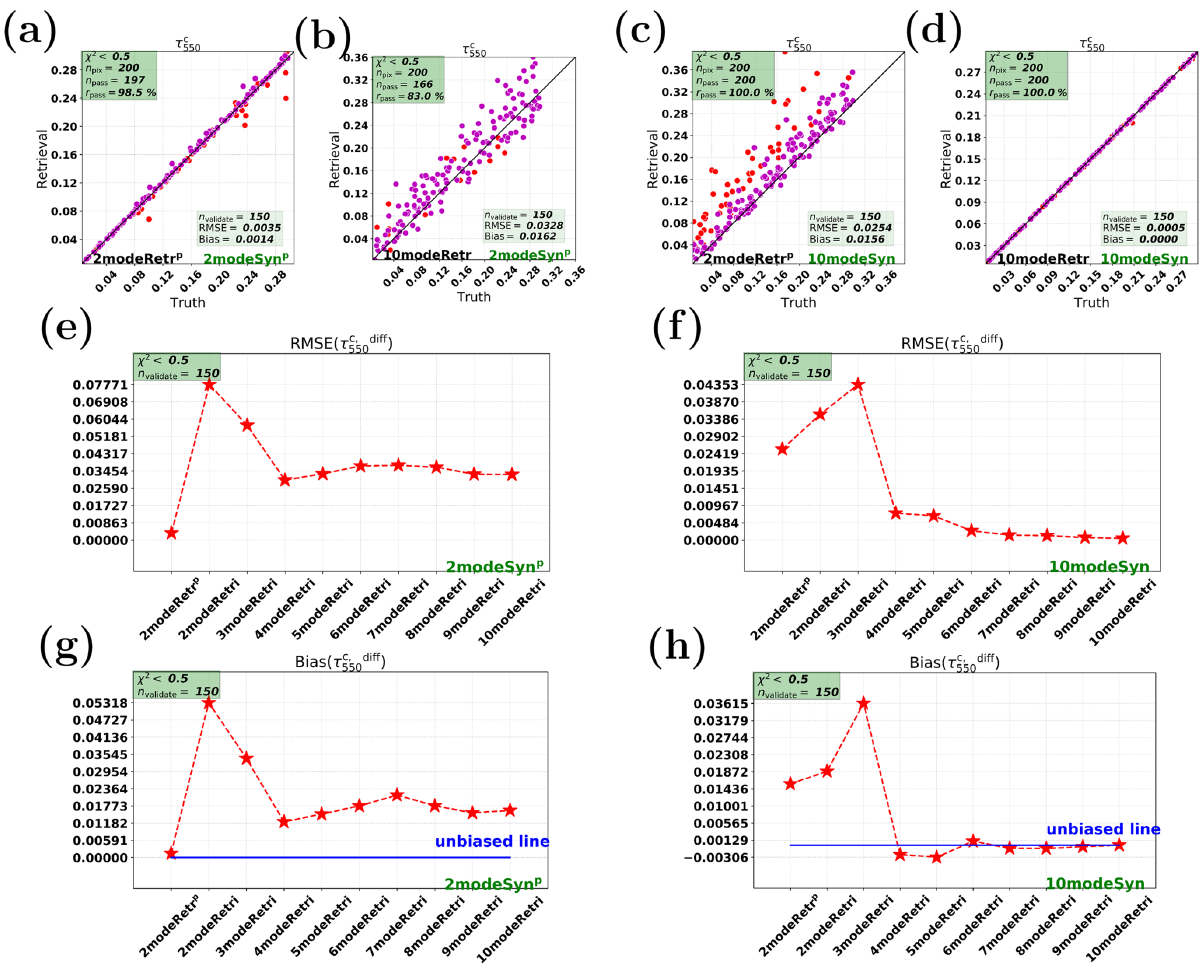
Figure 4. Synthetic retrievals for the AOT (at 550nm) of all the coarse modes ( τ c 2modeSyn p and 10modeSyn, respectively.